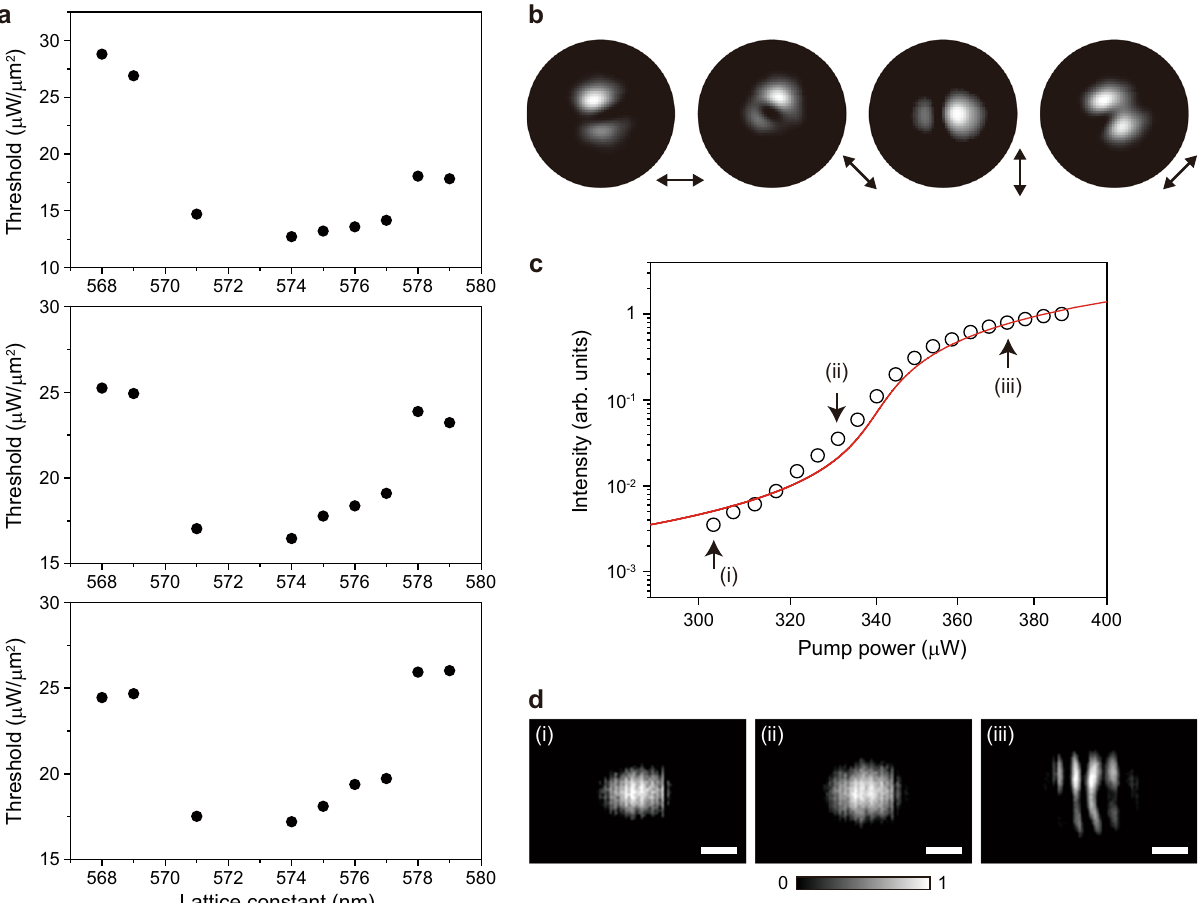
Fig. 5 Lasing properties in the super-BIC regime. a Measured threshold values divided by the pump area as a function of the lattice constant, when the pump spot sizes are ~6.7 μ m (top), ~8.0 μ m (middle), and ~9.2 μ m (bottom). b Measured polarization-resolved lasing images as a function of the polarizer axis. c Comparison of the measured L – L curve (open dots) with that obtained from the rate equations (red curve) in the log – log scale. The main parameters used in the rate equations are shown in “ Methods ” section. The estimated spontaneous emission factor is ~0.01. d Measured interference images in the near fi eld, for (i) 303 μ W, (ii) 331 μ W, and (iii) 373 μ W in the graph of c . (i), (ii), and (iii) correspond to the spontaneous emission, ampli fi ed spontaneous emission, and lasing regions, respectively. Scale bars, 10 μ m. All data in b – d were measured in the laser structure with a = 574